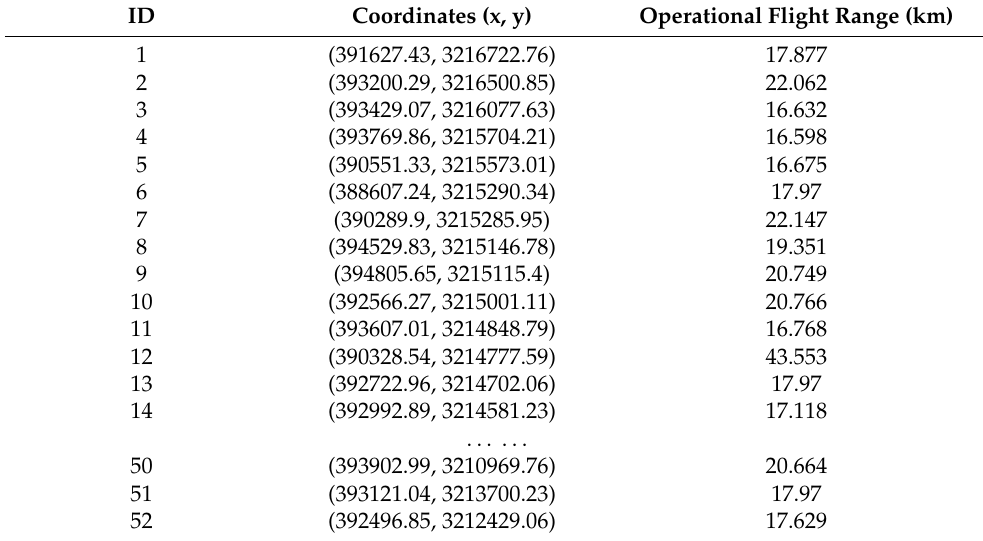
Table 1. Data acquisition task